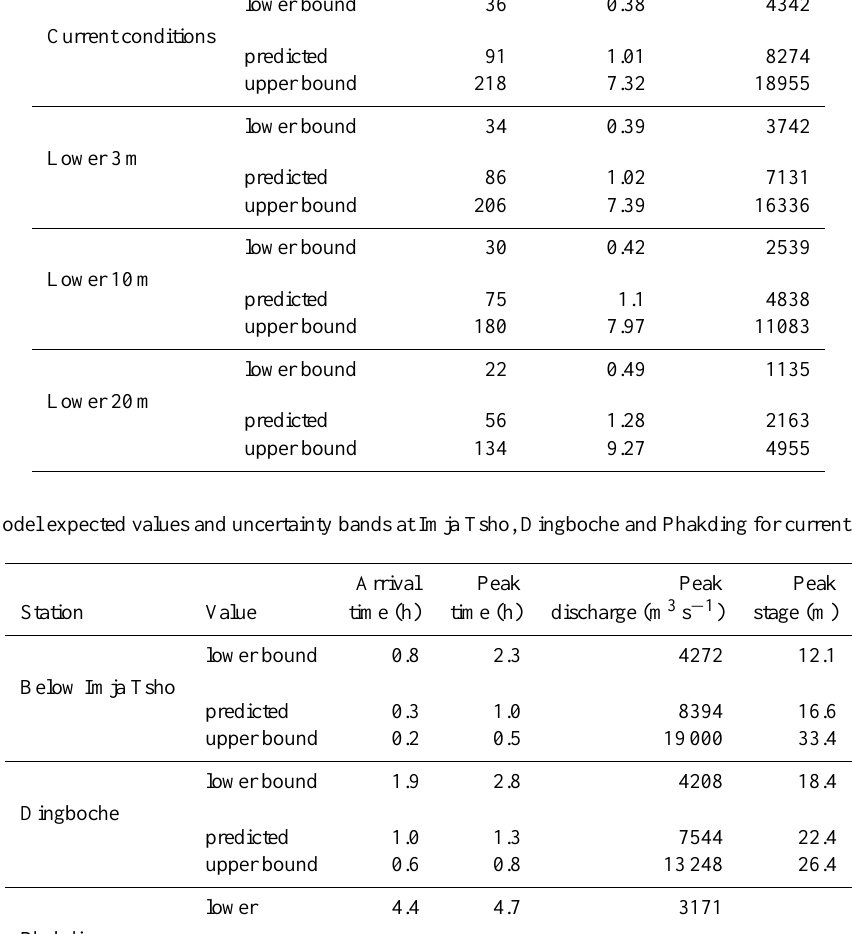
Table 3. Breach parameter expected values and uncertainty bands for four scenarios.